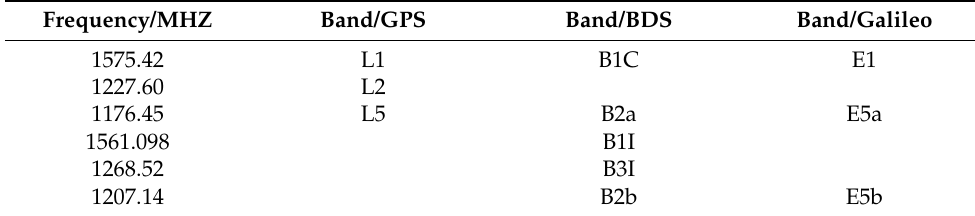
Table 1. Frequency and band of GPS, BDS and Galileo.